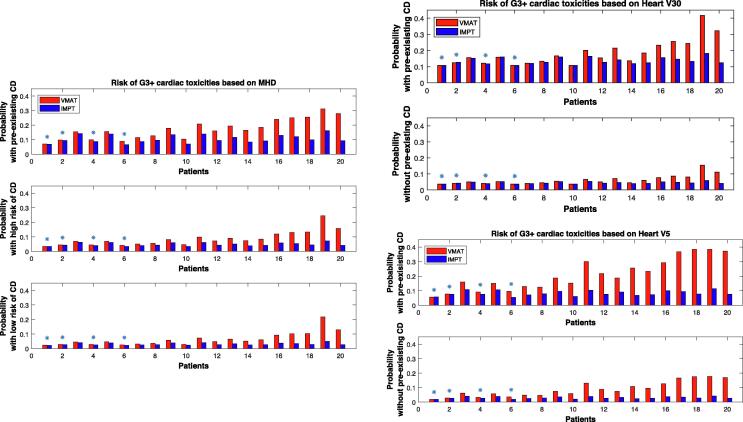
Risk of grade ⩾3 cardiac toxicities based on MHD. Asterisks indicate patients with disease not extending to and below T7 vertebrae.